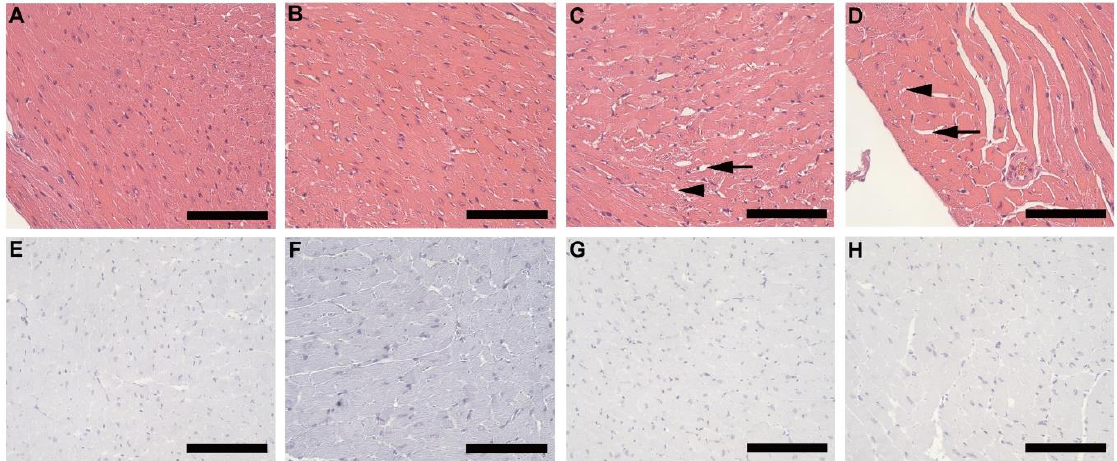
Figure 6. Histology and immunohistochemistry of heart tissue. Histology of heart tissue from CD females, ( A ); CD males, ( B ); HFD females, ( C ); and HFD males, ( D ); showed enlarged myocardial fibers and surrounding fibrocollagenous tissue (black arrow) in HFD animals as well as lipid droplets (arrowhead) that lies between the myocardial fibers in the HFD animals. These features were more prominent in HFD males. F4/80+ immunostained sections from CD females, ( E ); CD males, ( F ); HFD females, ( G ); and HFD males, ( H ); showed the absence of macrophages in heart tissues of all experimental groups. Scale bar: 100 µm .